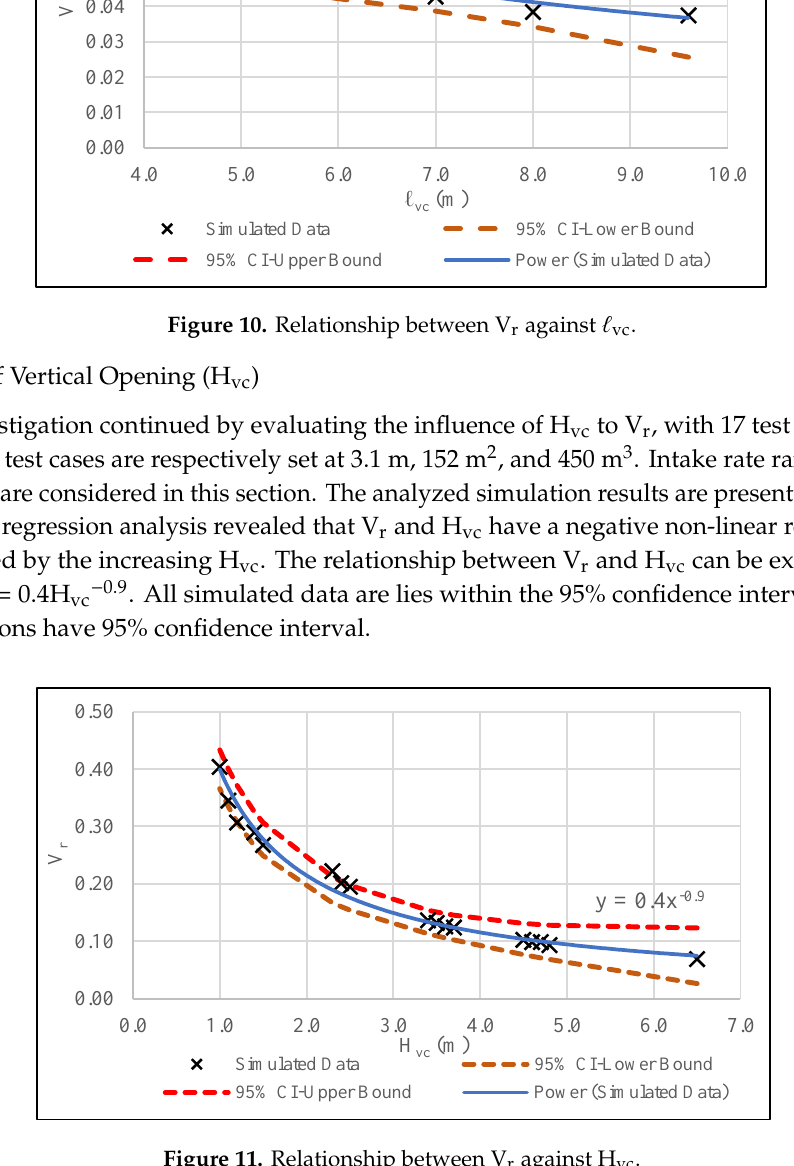
Figure 11. Relationship between V r against H vc.